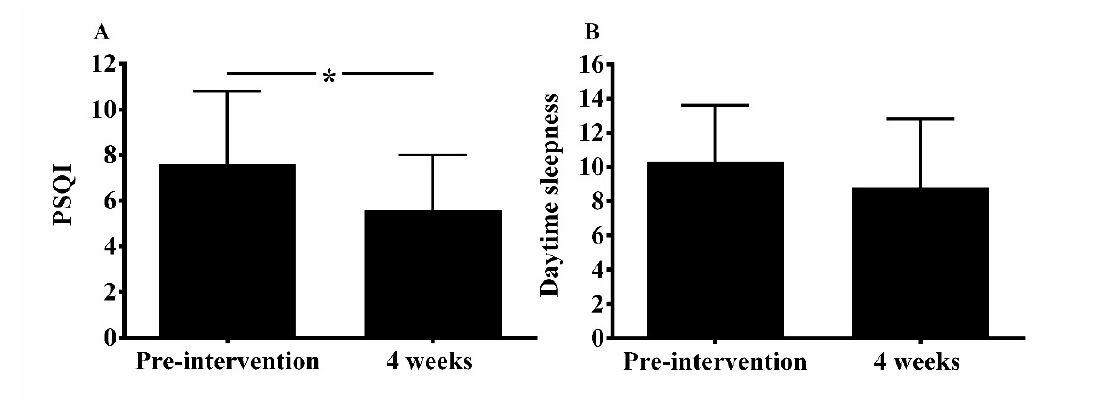
Figure 1. PSQI (Panel A) and daytime sleepiness (Panel B) before and after four weeks of resistance training in